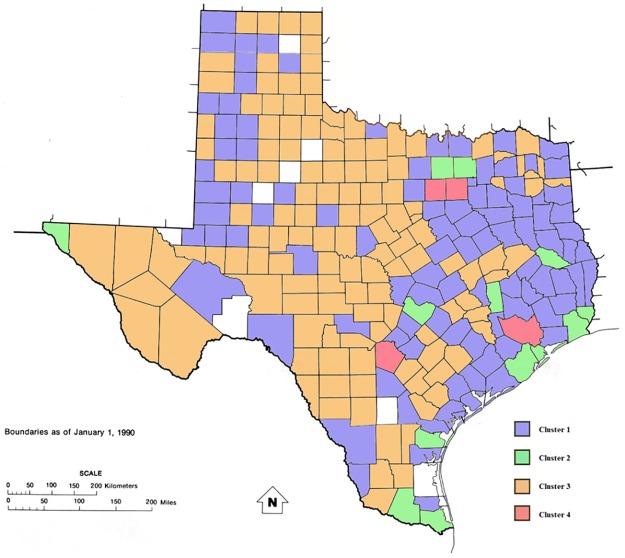
Map of current Texas counties with boundaries as of January 1, 1990 showing all 4 clusters: Cluster 1—blue; Cluster 2—green; Cluster 3—orange; Cluster 4 –red.